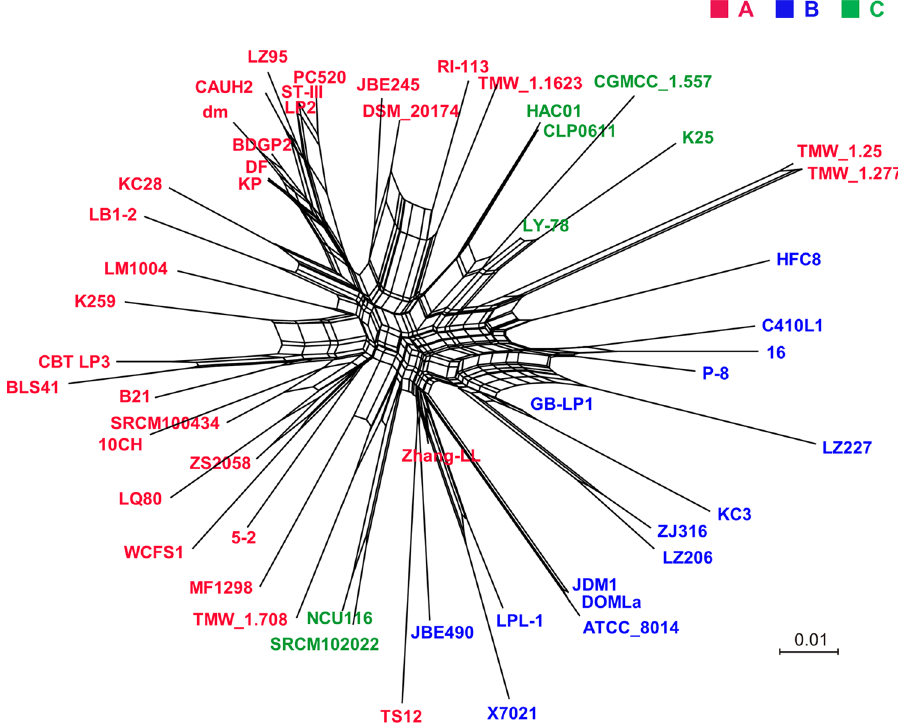
Figure 1. Network tree of Lactiplantibacillus plantarum subsp. plantarum showing the possibility of nonvertical evolution among strains. The network tree was generated using the SplitTree 4 program based on a binary matrix of the presence and absence of gene families generated using the Ortho-MCL program. Reticulations in the tree indicate the possibility of horizontal gene transfer between branches. The red, blue, and green letters indicate the strains belonging to lineages A, B, and C,